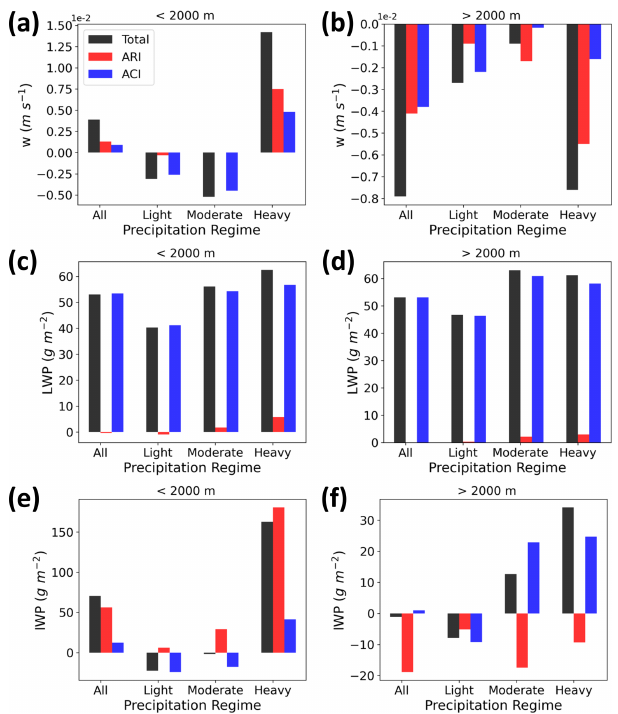
Figure 12. Mean perturbation of (a, b) vertical velocity, (c, d) LWP, and (e, f) IWP over the CenHim region for the terrain elevation below (a, c, e) and above (b, d, f) surface elevation of 2000ma.s.l., for total, light, moderate, and heavy precipitation